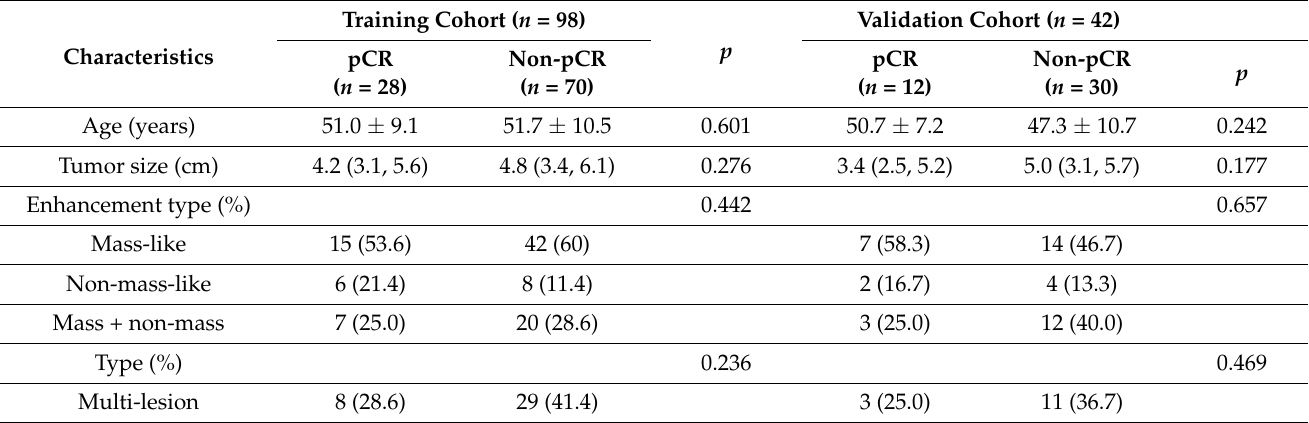
Table 1. Comparison of clinicopathological characteristics in the training and validation